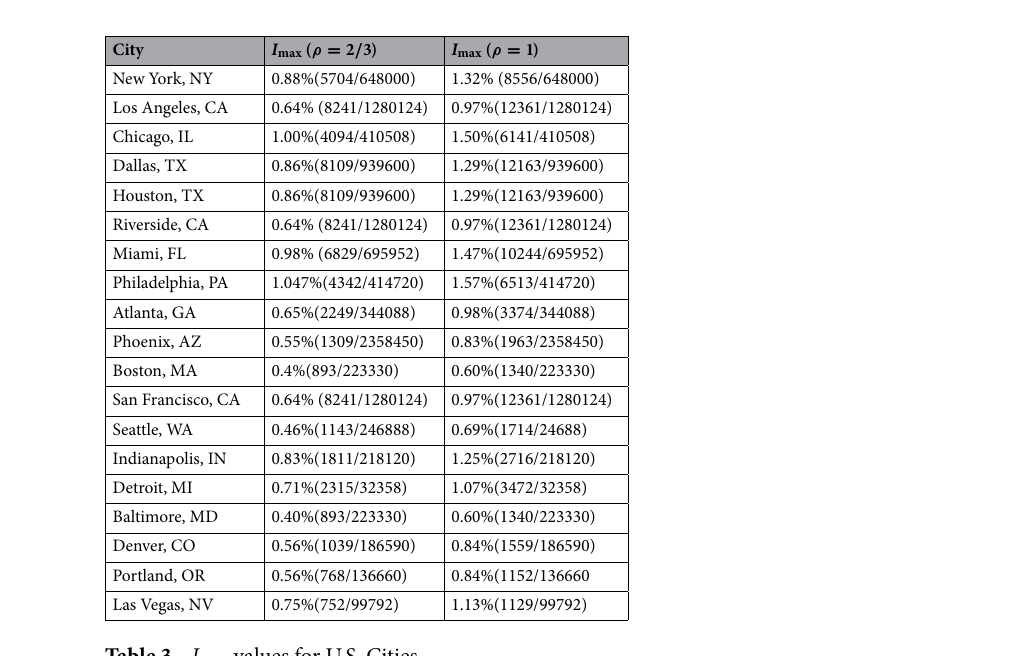
Table 3. I max values for U.S.